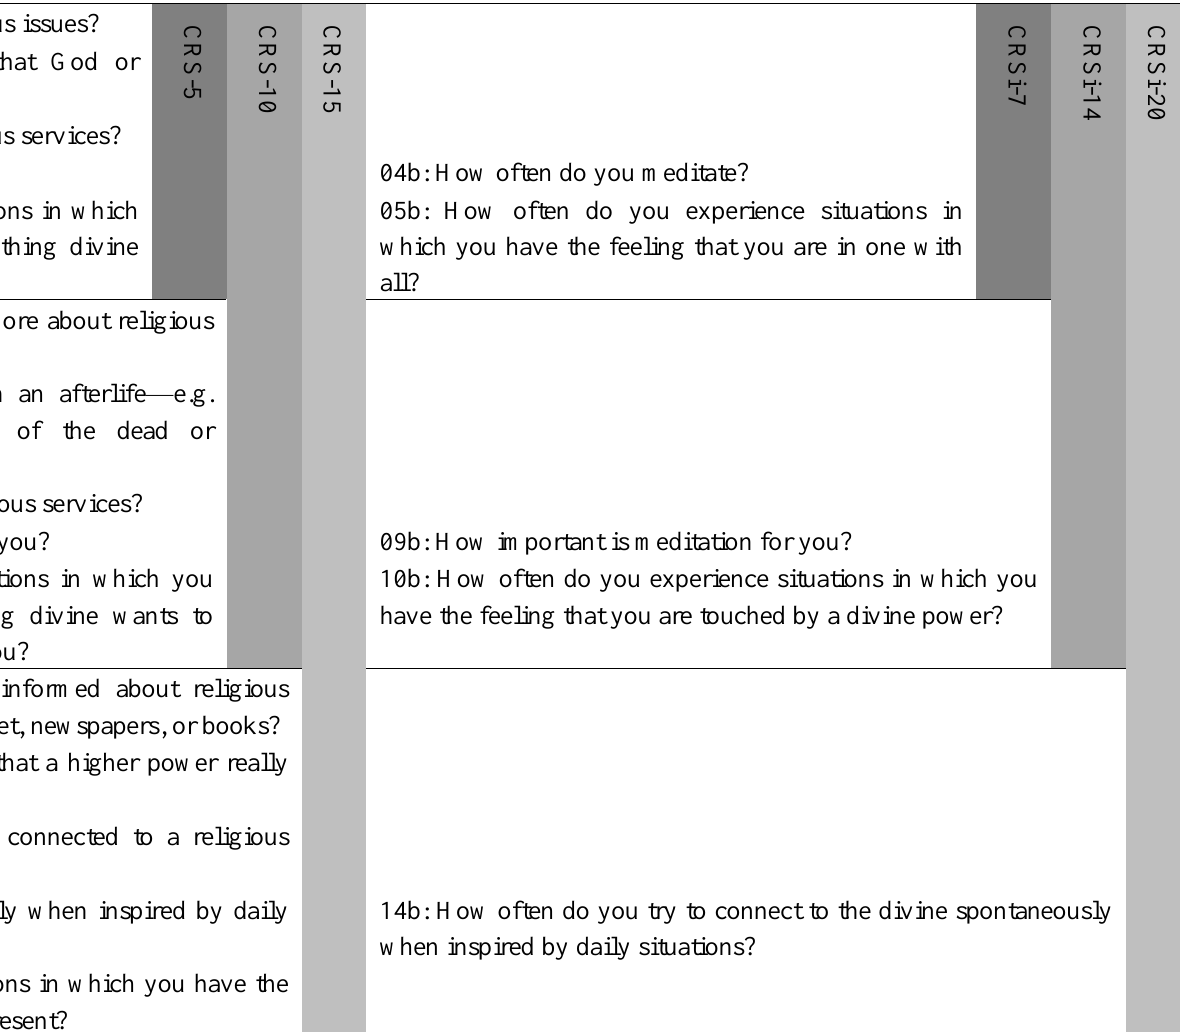
Additional Items for the interreligious versions CRS versions only